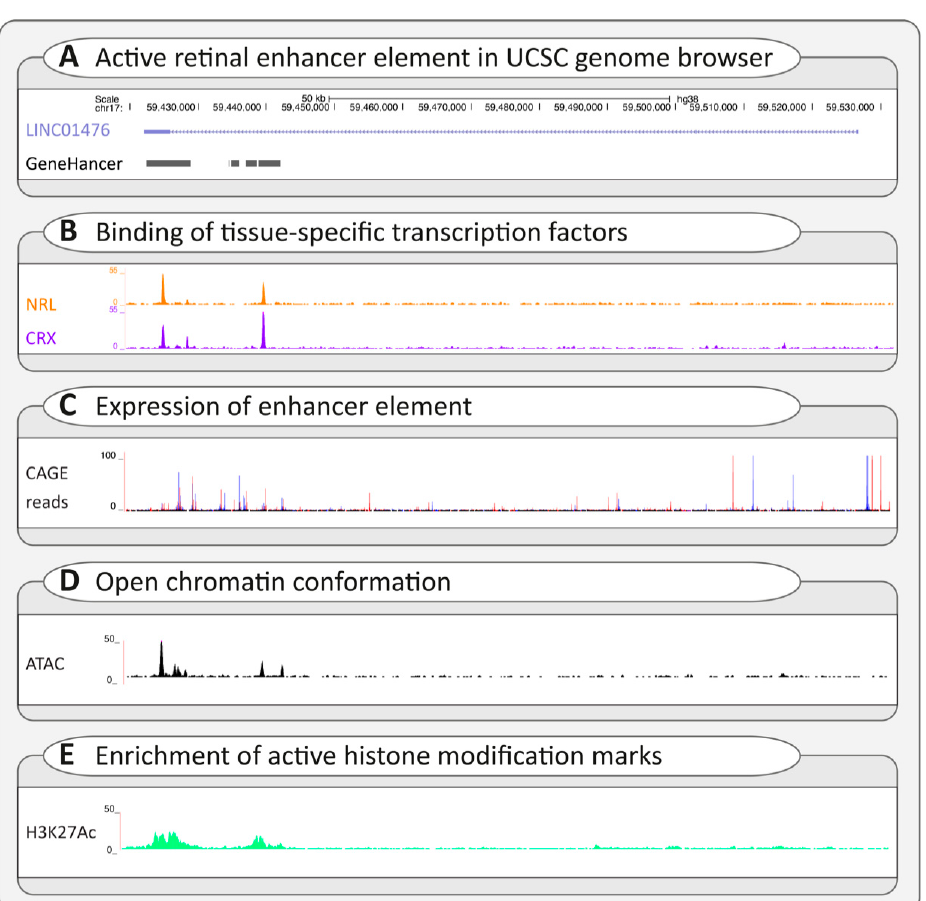
Figure 4. Interpretation of potential regulatory variants using the University of California